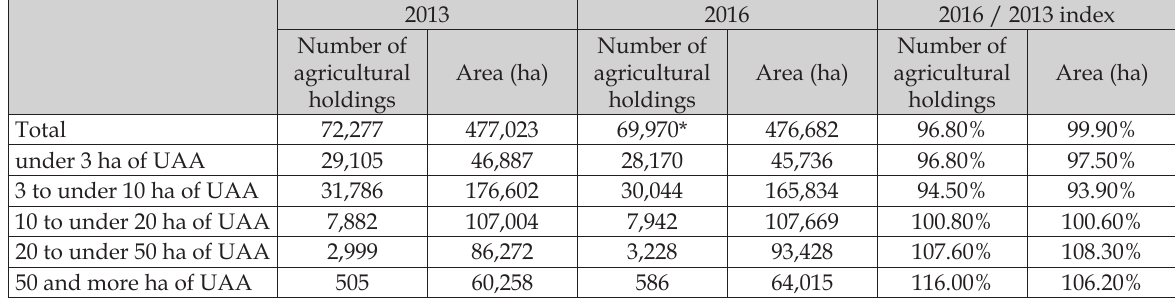
Table 1. Agricultural holdings by UAA in Slovenia